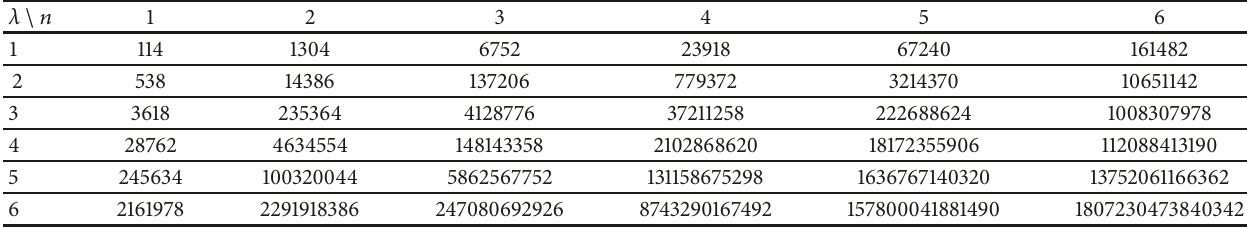
Table 5: Modified hyper Wiener index of 𝑅𝑇𝑂𝑋 .